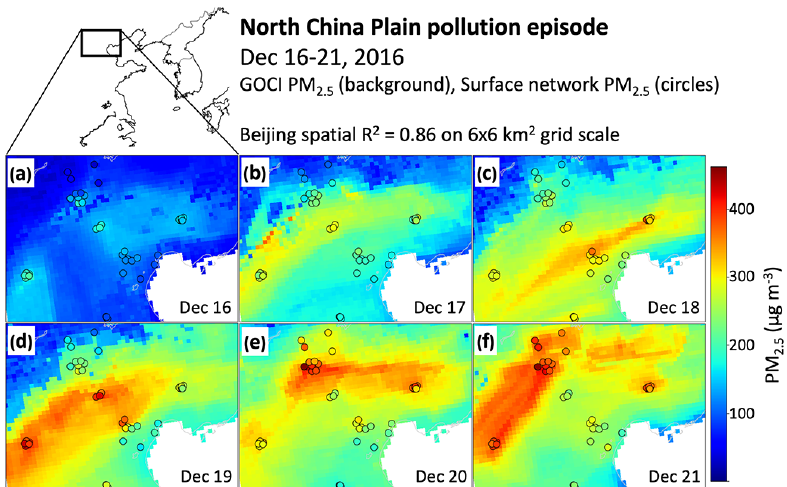
Figure 10. Same as Fig. 9 but for a pollution event in Beijing on 16–21 December